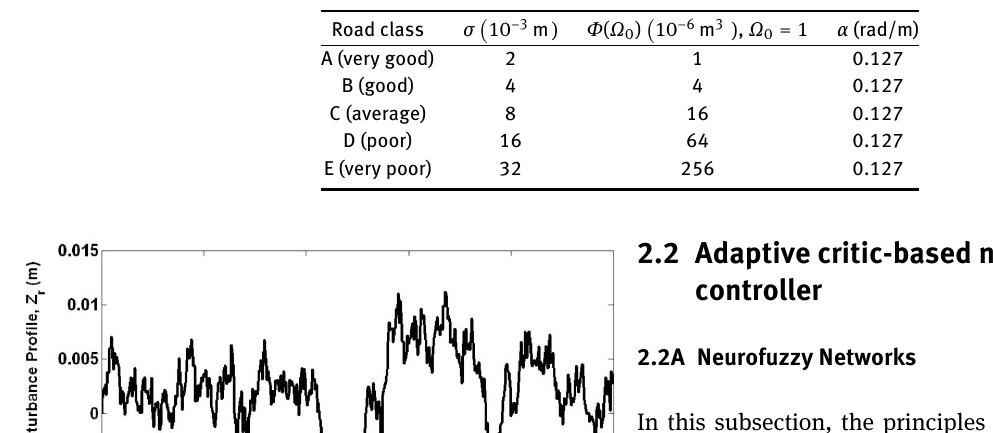
Table 3. Road roughness standard deviation